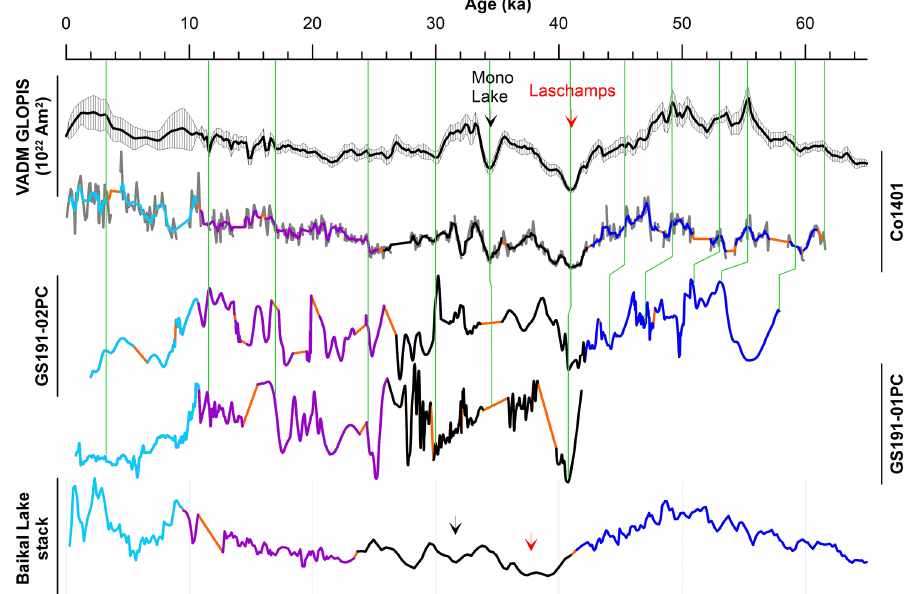
Figure 9. Comparison of the smoothed RPI(IRM) of Co1401 (non-smoothed data in grey colours in the background) with RPI records from Lake Baikal (Baikal Lake stack) and the Barents Sea (GS191-01PC and GS191-02PC) and the VADM of GLOPIS-75-GICC05. All records are normalized to the respective maxima. For discussion, the RPI records are divided into four parts by colour code (light blue, purple, black, and royal blue). Gaps in the individual records are marked in orange. Please note the different ages assigned to the RPI characteristics of the different datasets, leading to a shift of the patterns against each other (see Sect. 3.4). Tie lines are shown as in Fig. 6. For the Baikal Lake stack, only the main grid lines are provided, as correlation is not readily possible. The locations of geomagnetic excursions are indicated by tie lines and